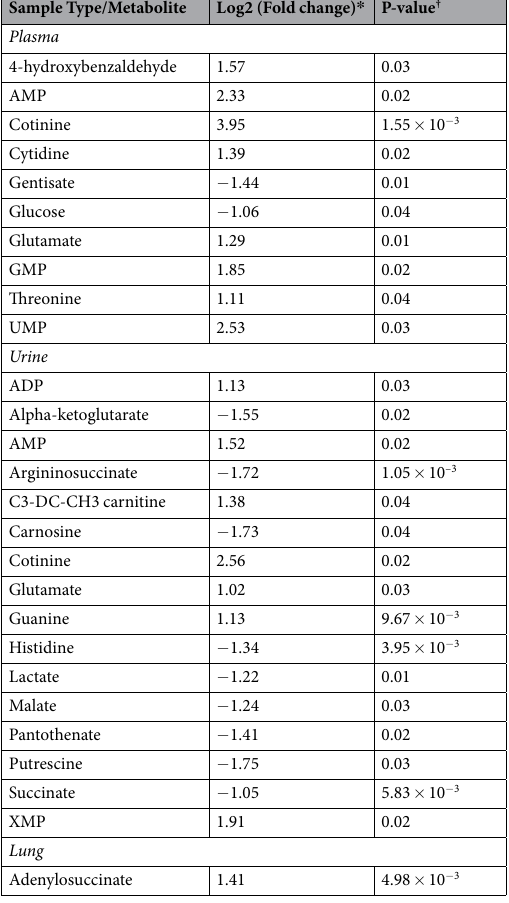
Table 3. Metabolites with differential concentrations following exposure to chronic cigarette smoke exposure in (Hhip + / − ) heterozygote mice. * Negative values indicate lower concentration in Hhip + / − mice exposed to chronic cigarette smoke (minimum 2x fold change). † Student’s